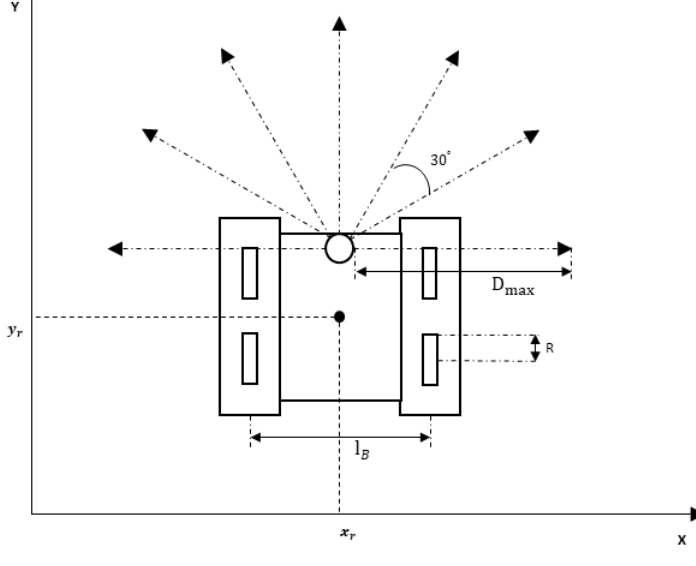
Figure 1. Schematic diagram of the tracked robot.